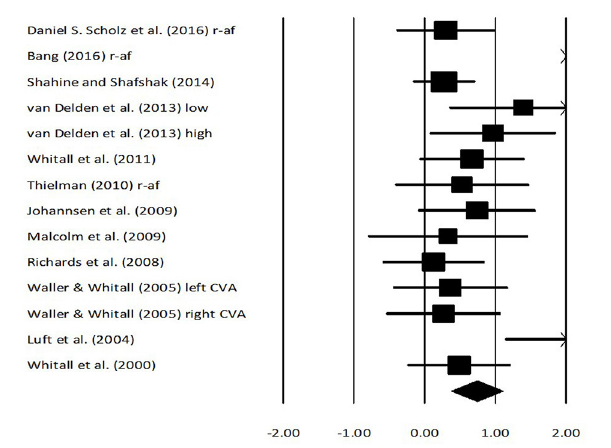
FIGURE 4 | Forest plot illustrating individual studies evaluating the effects of rhythmic auditory cueing, and real-time auditory feedback on Fugl Meyer assessment scores on arm function amongst post stroke patients. Weighted effect sizes; Hedge’s g (boxes) and 95% C.I (whiskers) are presented, demonstrating repositioning errors for individual studies. The (Diamond) represents pooled effect sizes and 95% CI. A negative effect size indicated reduction in Fugl Meyer scores depicting poor arm functioning; a positive effect size indicated enhancement in Fugl Meyer scores depicting better arm functioning. (r-af, Real-time auditory feedback; low, Low performance group; high, High performance group; left CVA, Left sided cerebrovascular accident; right CVA, Right sided cerebrovascular accident).